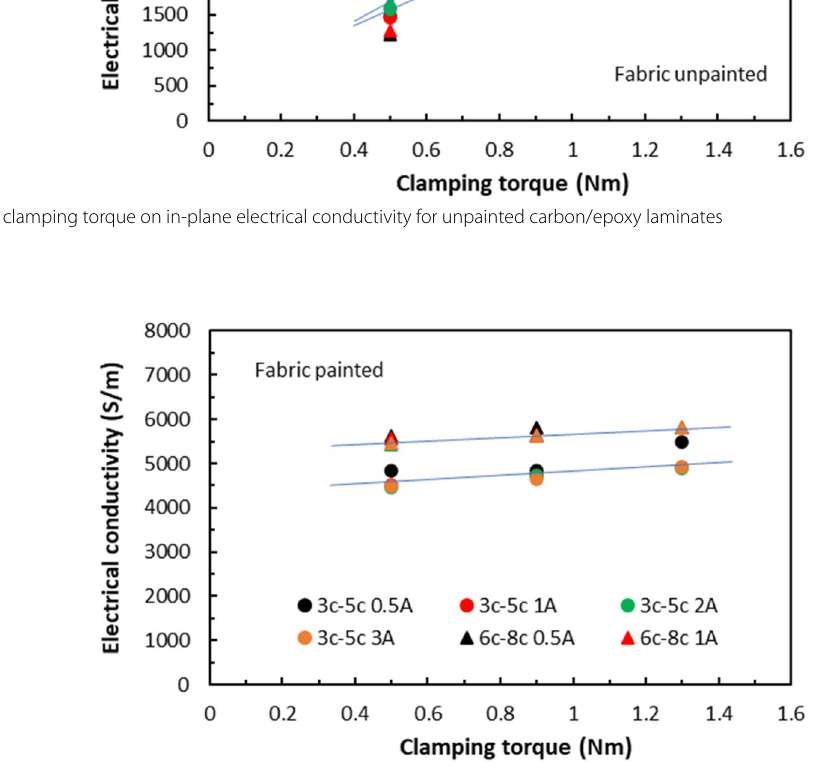
Fig. 17 Effect of clamping torque on in-plane electrical conductivity for painted carbon/epoxy